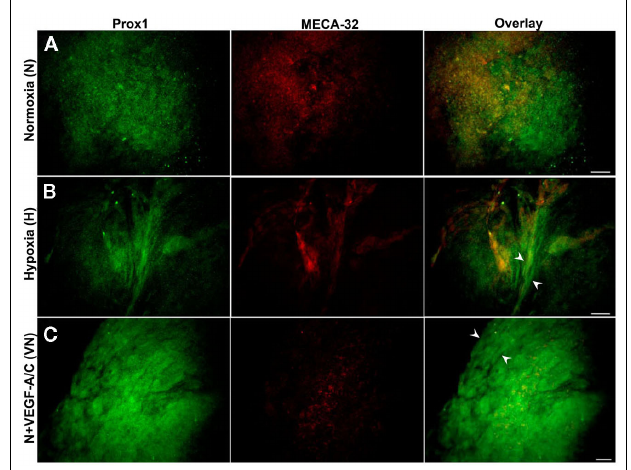
FIGURE 4 | Digital images (without magnification) of EBs at E22.5 grown under (A) N + VEGF-A/C (VN) and (B) H + VEGF-A/C (VH) treatments reveal contact of adjacent EBs to form cord-like structures, as marked by arrowheads. Representative result from 4 different experiment sets is shown.